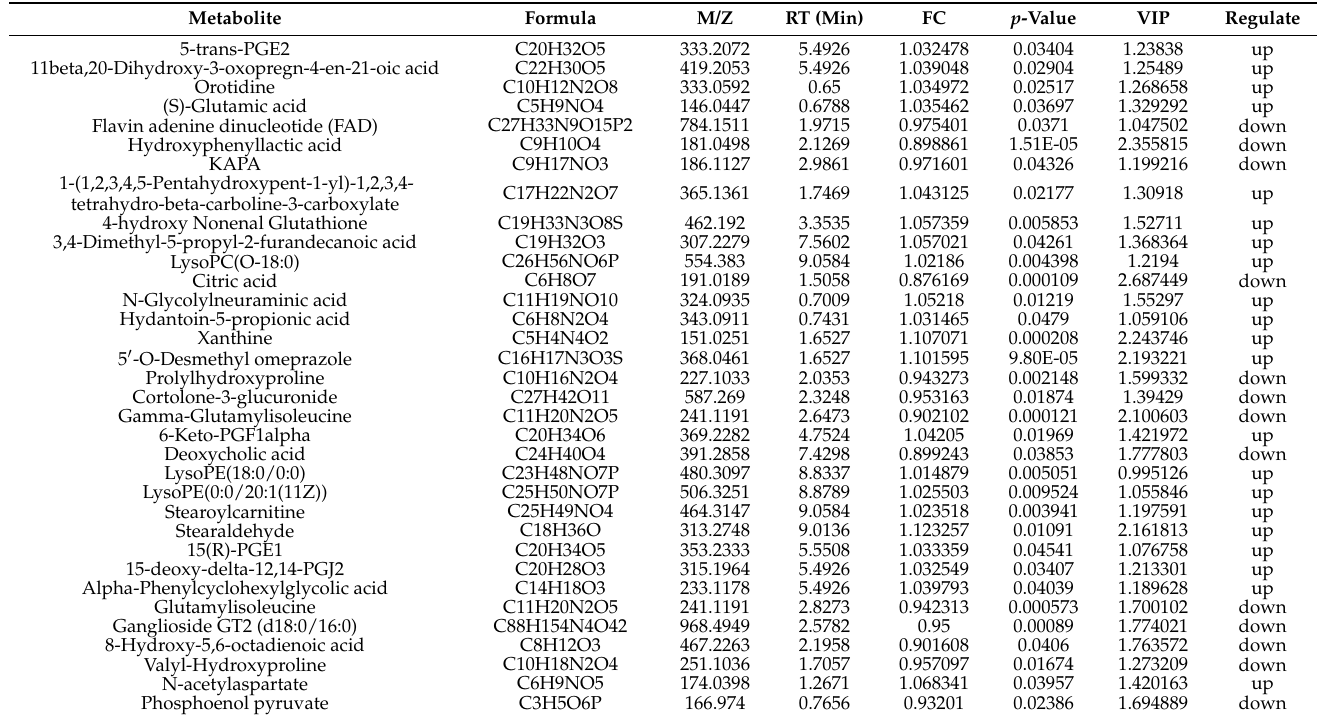
Table 2. Positively identified significantly differentially expressed metabolites in the dermal papilla cells after copper treatment under negative ion mode ( n =